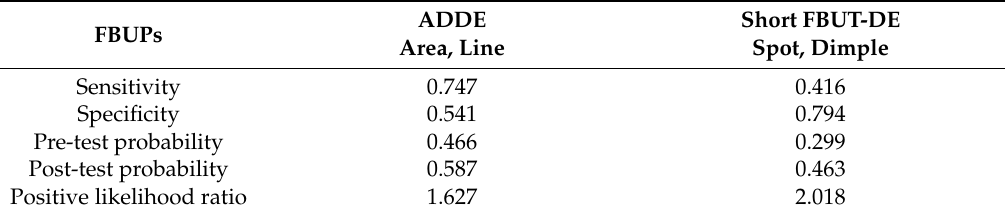
Table 3. Tear breakup patterns of aqueous deficient dry eye and short fluorescein breakup time dry eye subgroups. Table 4. FBUPs results for ADDE and short FBUT-DE. results are shown in percentage (%). Table 4. FBUPs results for ADDE and short FBUT-DE.